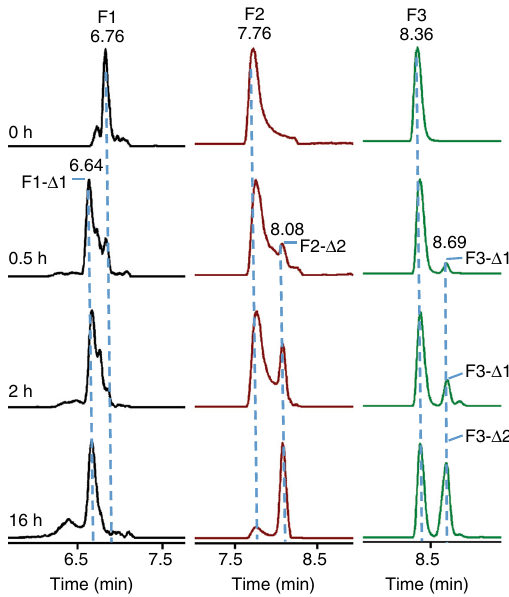
Fig. 5 Overall directionality of AMdnC in processing AMdnA. Extracted ion chromatograms of the fragments of intact and processed AMdnAs at different time points revealed the unstrict but favored N- to- C overall directionality of AMdnC. F3- Δ 1 and F3- Δ 2 had the same retention times in LC-HR-MS